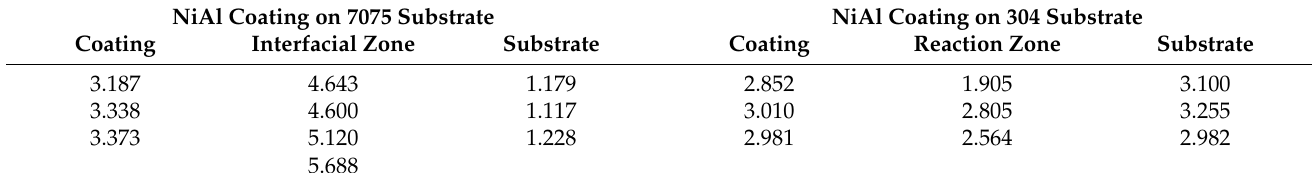
Table 8. Microhardness (GPa) of the relevant spots.